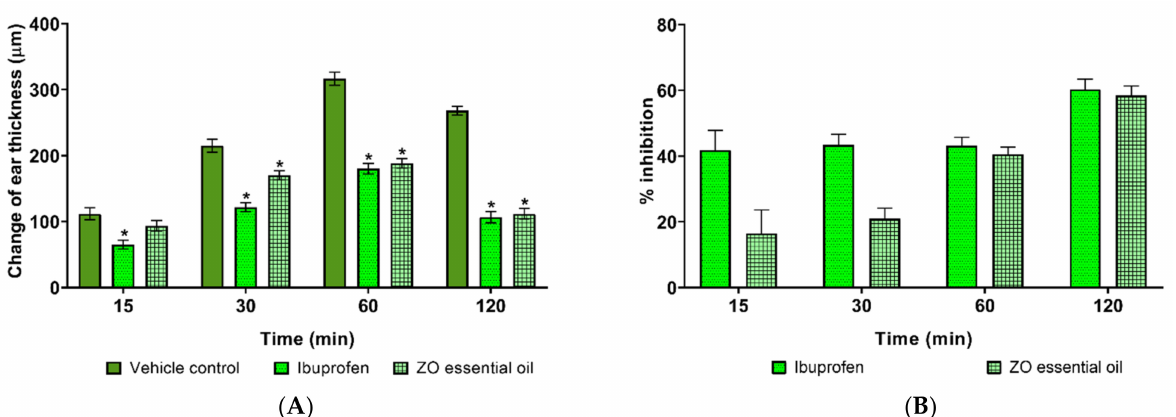
Figure 1. Effects of ZO essential oil and ibuprofen on EPP-induced ear edema in rats. ( A ) Mean changes in ear thickness ( µ m) and ( B ) the percentages of ear edema inhibition after pretreating with ZO essential oil (3 mg/ear) or ibuprofen (1 mg/ear) at different time points. Data represent the mean ± SEM ( n = 6). * Denotes significant differences ( p < 0.05) compared to the control